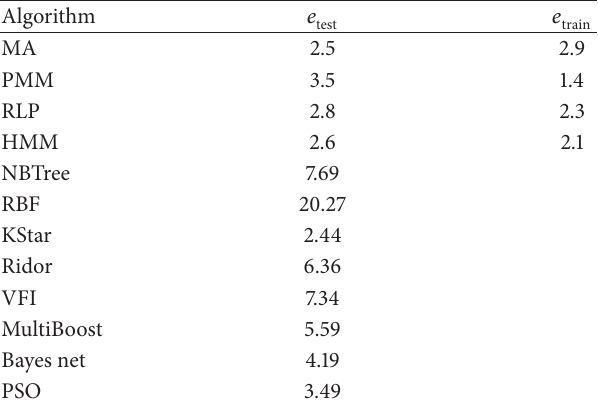
Table 5: Results in the heart dataset.